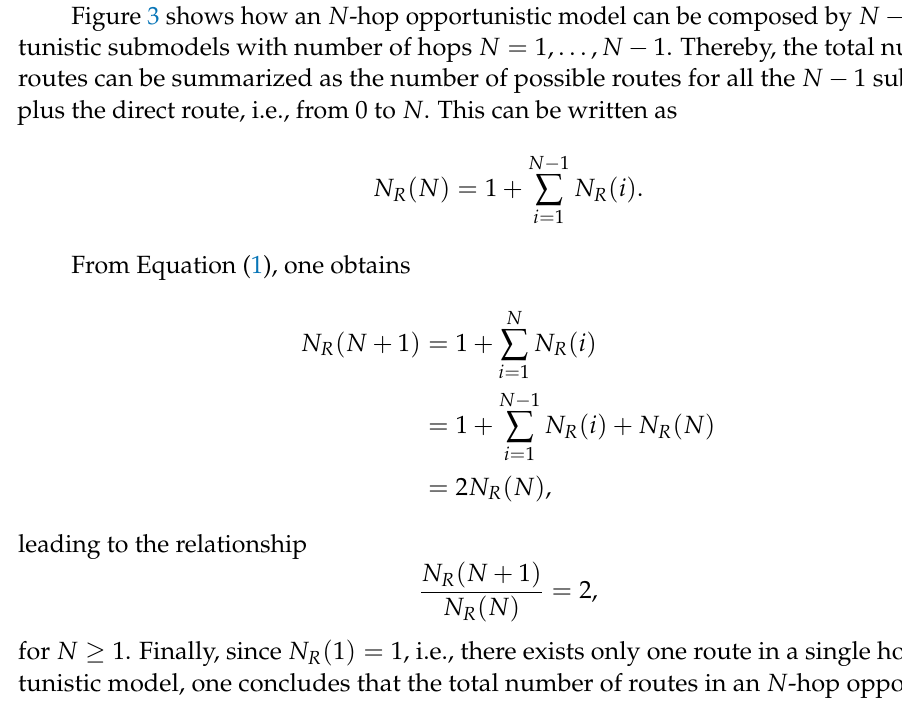
Figure 3. N -hop opportunistic models for N = 1,2,3. Colors are used to depict that an N -hop opportunistic model has N − 1 opportunistic submodels